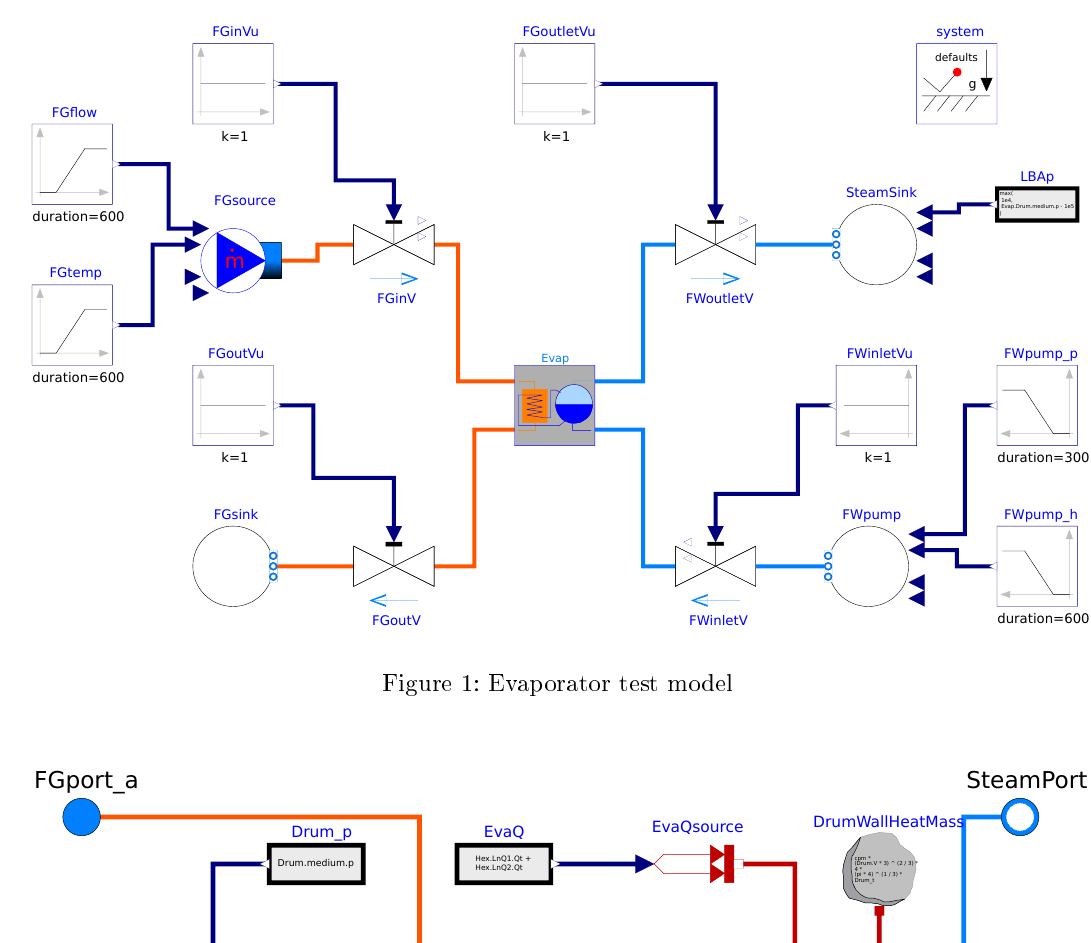
Figure 1: Evaporator test model